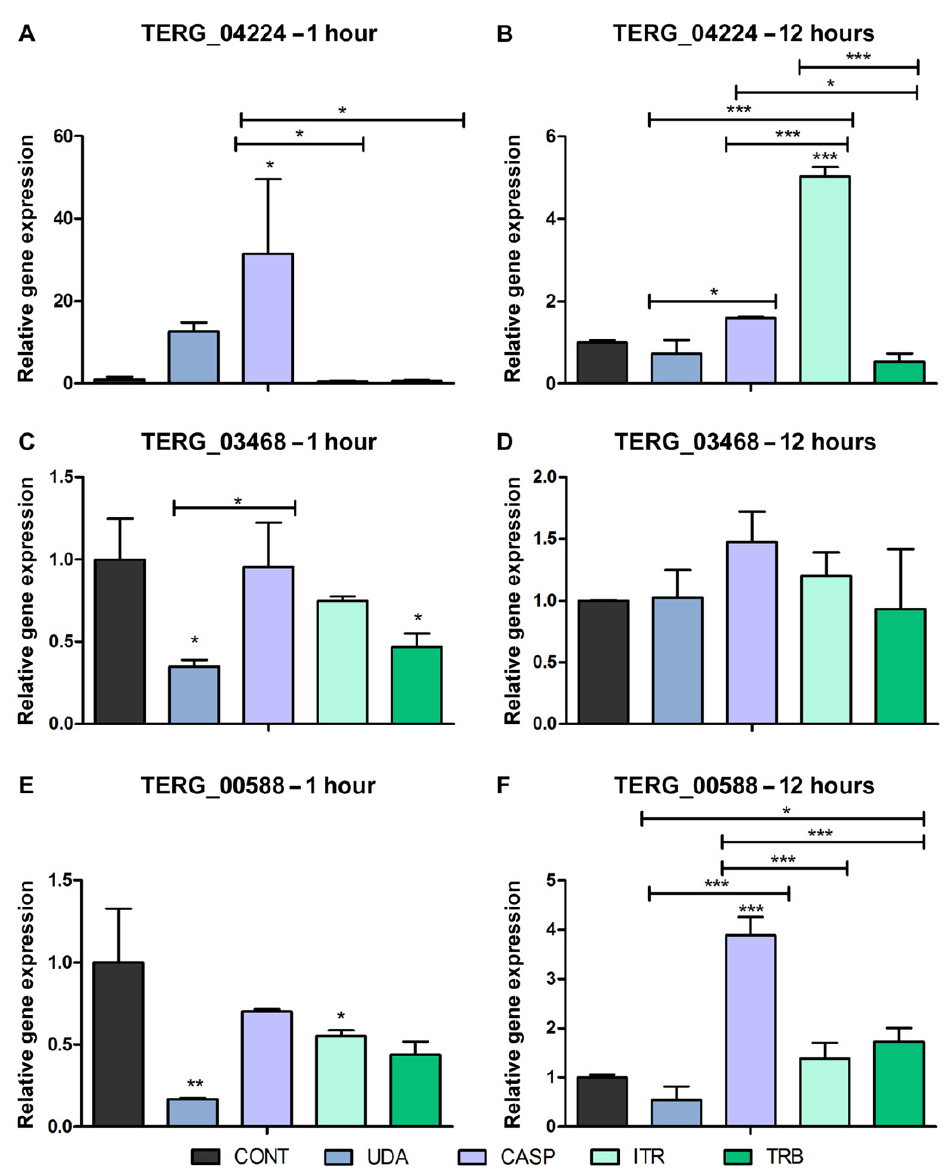
Figure 4. RT-qPCR analysis of expression levels of T. rubrum genes that putatively interact with the TERG_04309. Gene modulation data for TERG_04224 ( A , B ), TERG_03468 ( C , D ), and TERG_00588 ( E , F ) after 1 and 12 h of antifungal agent exposure. Statistical analysis was performed using the t -test method. Asterisks refer to * p < 0.05, ** p < 0.01, and *** p < 0.001. As a reference for modulation, the condition of paired controls of 1 h and 12 h was used. Control sample (CONT); undecanoic acid (UDA); caspofungin (CASP), itraconazole (ITR), and terbinafine (TRB).